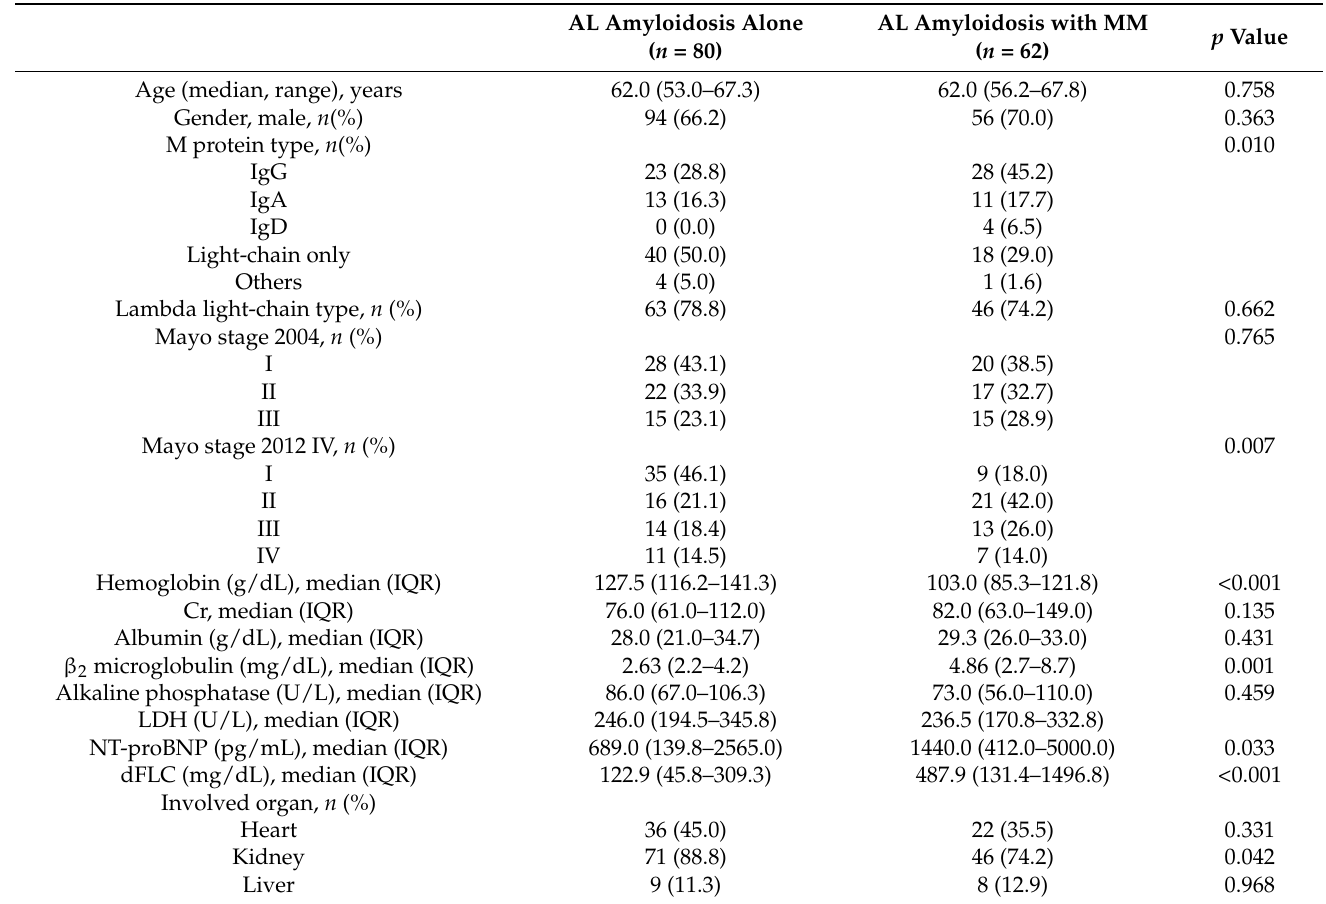
Table 1. Baseline characteristics of AL amyloidosis patients, with or without concurrent multi- ple